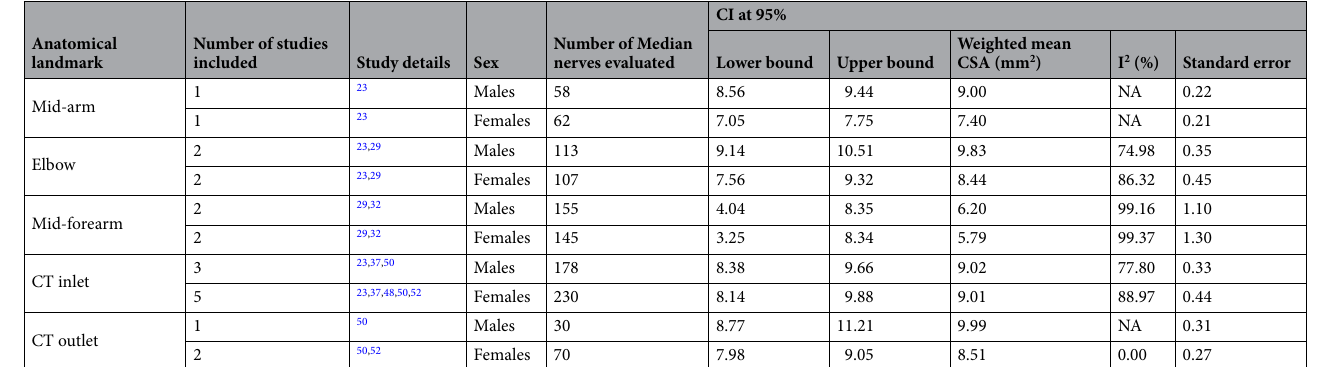
Table 3. Subgroup analysis (of included studies, n = 7) based on sex at different anatomical landmarks measuring median nerve CSA. CSA = cross sectional area. CI = confidence intervals. NA indicates the inclusion of only one study for the analysis, hence heterogenicity (I 2 ) cannot be